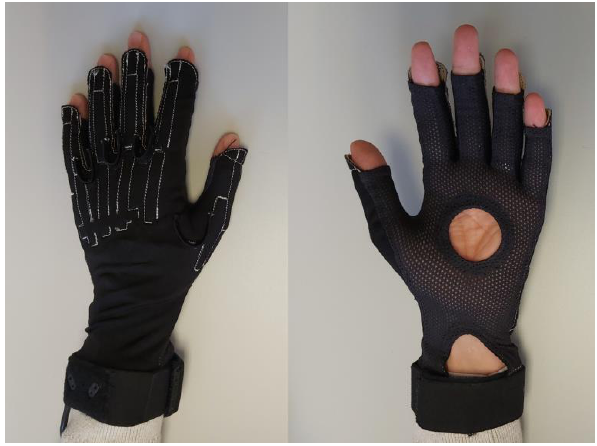
Figure 1. Dorsal ( left ) and palmar ( right ) views of the CyberGlove data glove. One CyberGlove model is equipped with 18 gauges and another with 22. Both gloves record flexion of proximal interphalangeal (PIP) and metacarpophalangeal joints of index to little fingers (8 DoF), abduction between fingers (3 DoF), thumb carpometacarpal abduction and flexion (2 DoF), flexion of thumb metacarpophalangeal and interphalangeal joints (2 DoF), palmar arch (1 DoF), and wrist flexion and radioulnar deviation (2 DoF). The model with 22 gauges has 4 additional gauges to record the flexion/extension of distal interphalangeal (DIP) finger joints (Figure 2).